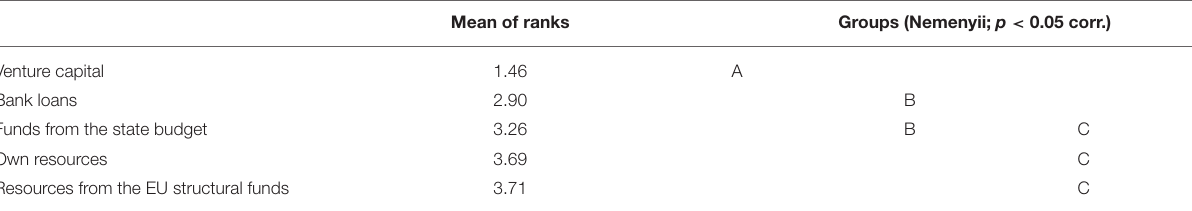
TABLE 3 | Importance and utilization of different financial sources for innovations. Mean of ranks Groups (Nemenyii; p < 0.05 corr.)